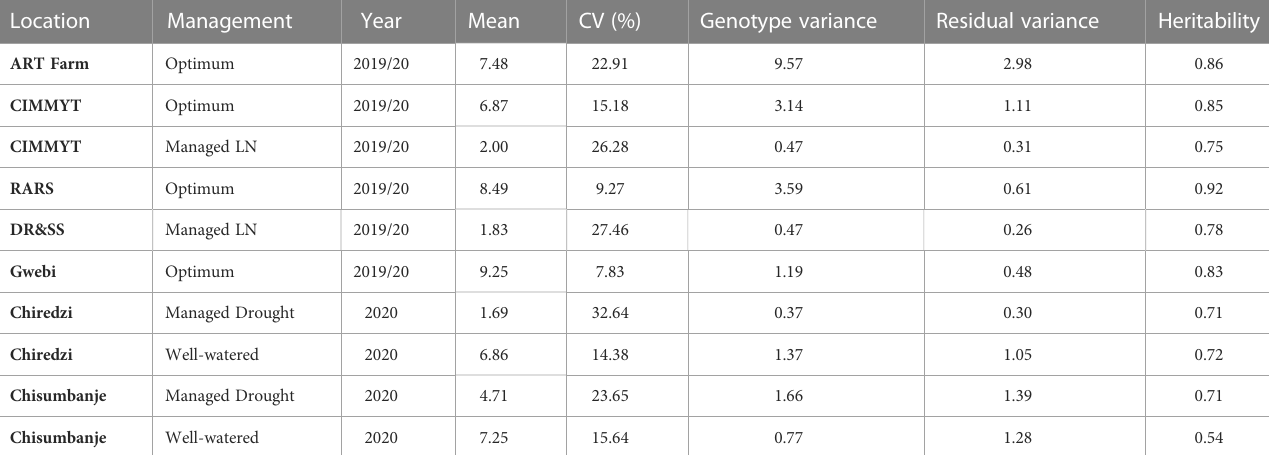
TABLE 5 Individual site characterization in terms of average grain yield, coef fi cient of variation (CV), heritability and variances of trials.